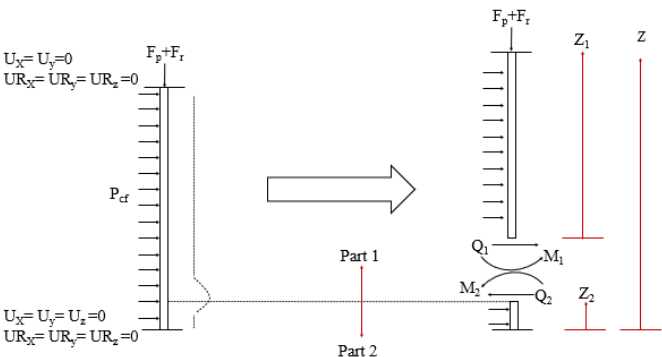
Figure 16. The domain of the elephant foot buckling problem in cylindrical plates.